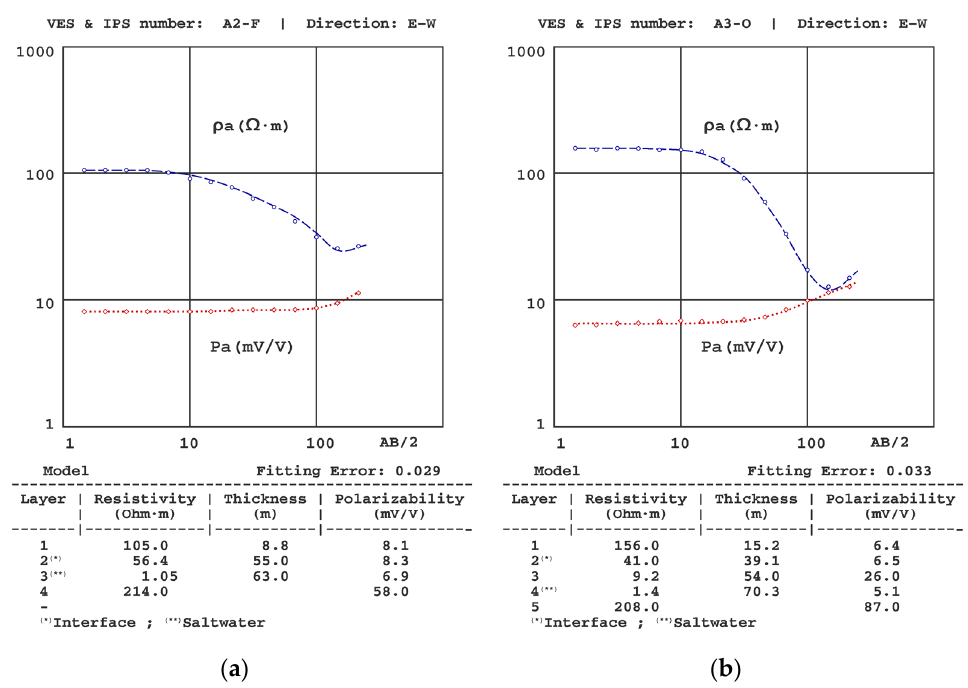
Figure 10. Results of the ( a ) A2-F VES-IPS and ( b ) A3-O VES-IPS, both obtained mid-autumn.